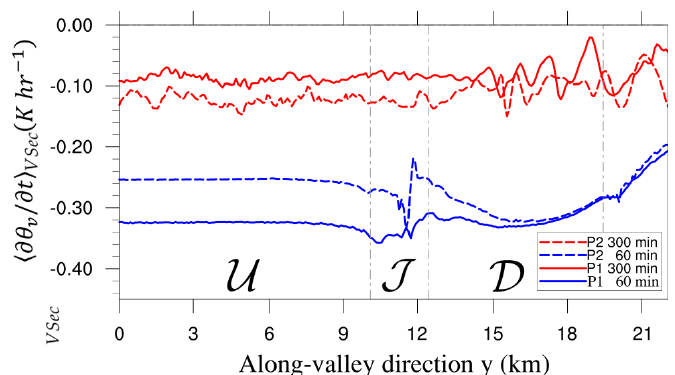
Figure 5. Average of the cooling rate over a cross-section extending up to the plateaux height ( (cid:104) ∂θ v / ∂ t (cid:105) VSec ) at the end of the first hour (blue line) and at the end of fourth hour (red line) of simulation (with a 10 min average) for P1 (solid lines) and P2 (dashed lines). Vertical grey dashed lines stand for the end of each section of the